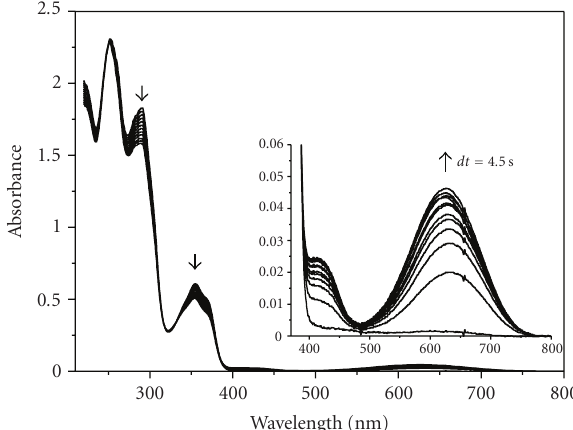
Figure 3: Absorption spectra of the compound 5a in acetonitrile ( C = 6,43 × 10 − 5 M, T = 30 ◦ C) under irradiation in stationary conditions by light λ max 365